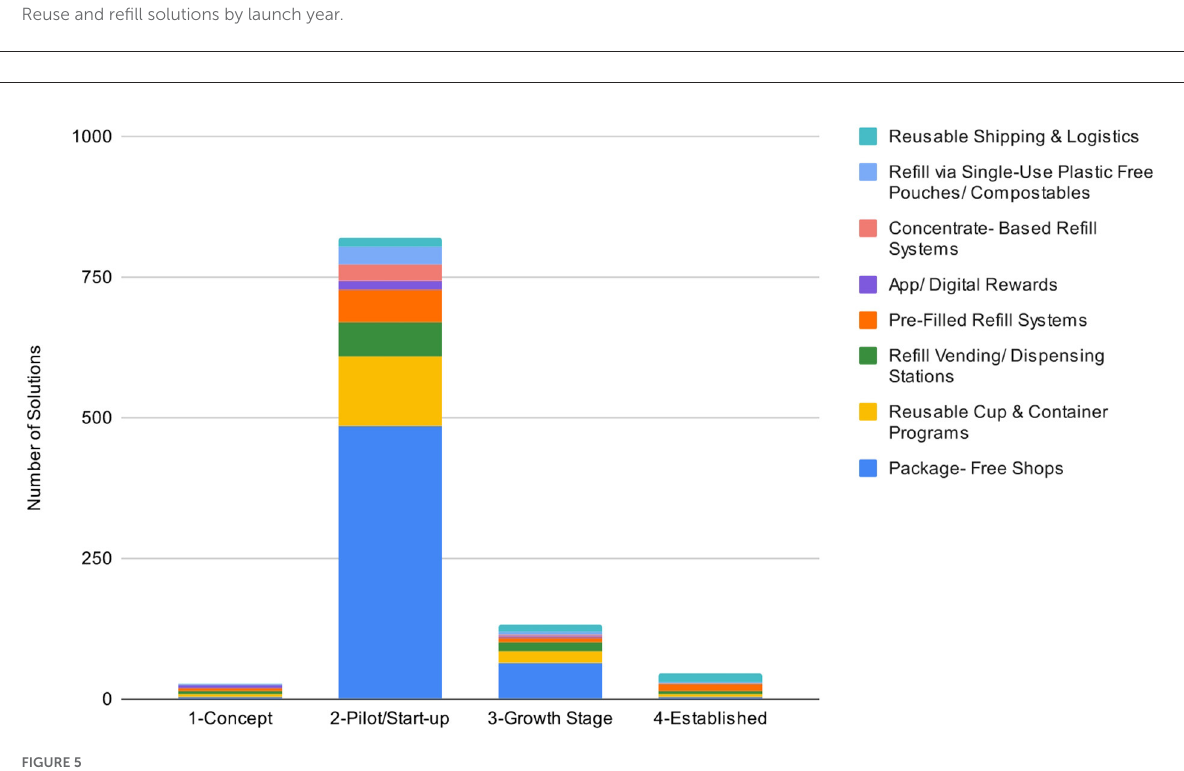
FIGURE5 Reuse and refill solutions by growth